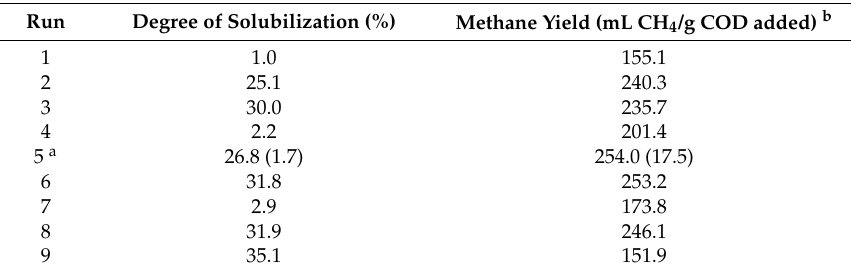
Table 3. Observed data from the experimental trials for response surface